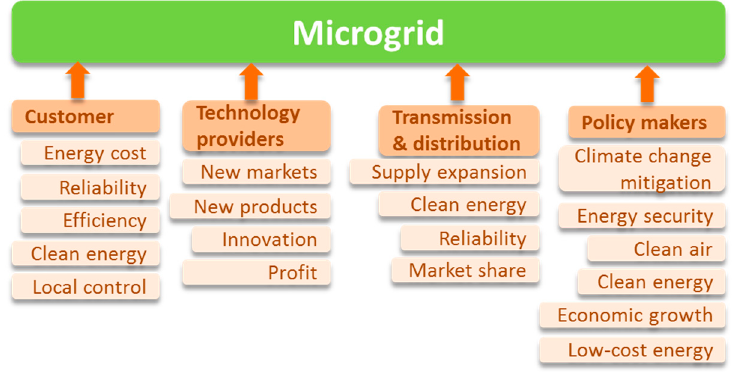
Figure 2. Drivers for microgrids across four stakeholder groups (adapted from Marnay et al. [24]).